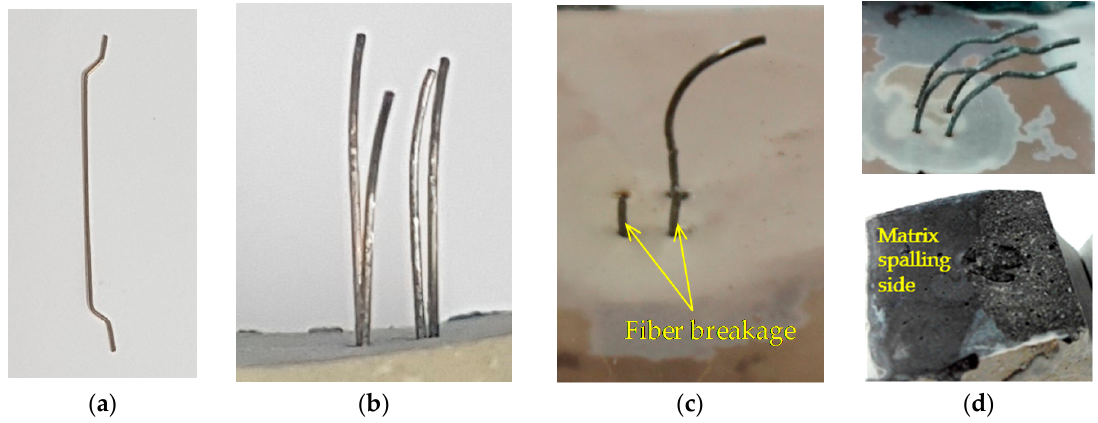
Figure 10. Pictures on various failure modes of H-fibers in UHPC: ( a ) original H-fiber, ( b ) aligned H-fiber, ( c ) H-fiber with an inclination angle of 30°, and ( d ) highly inclined H-fiber (i.e., 45° and 60°).